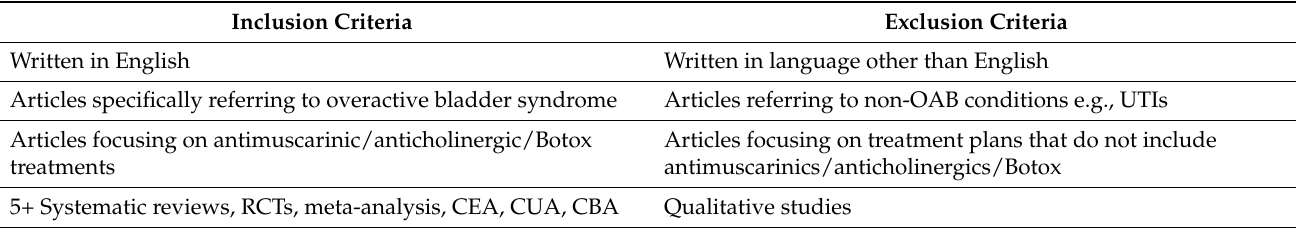
Table A9. Inclusion and exclusion criteria for literature